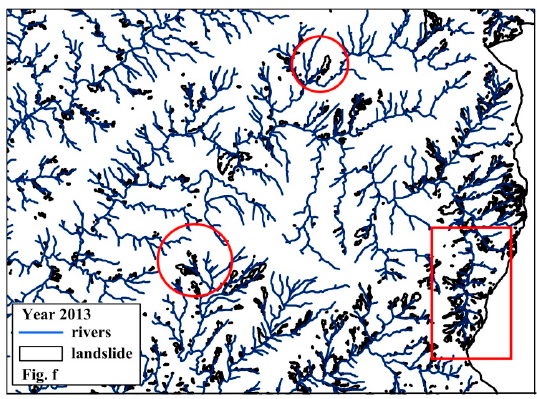
Figure 9. The long-term evolution of landslide in a sub-watershed of LRW (Figures 1 and 2) from 2003 to 2013.